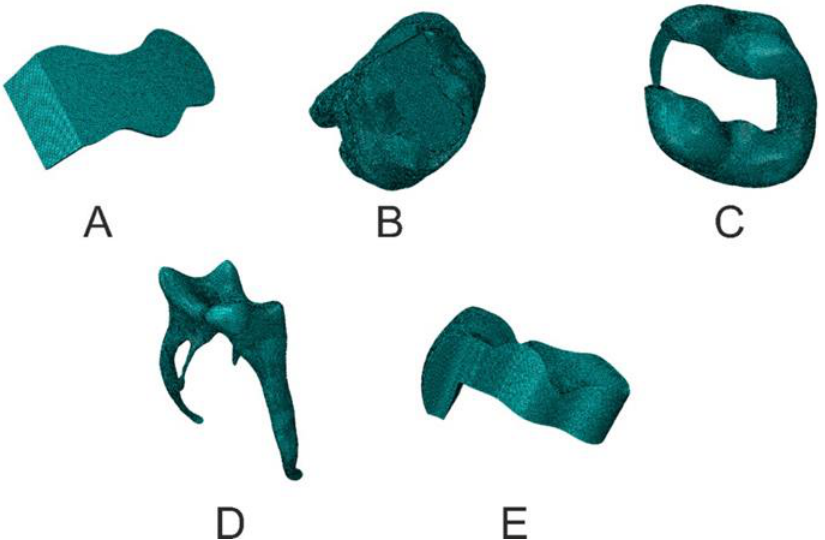
Figure 3. Geometric construction of molar tooth, restoration, and cement. ( A ): cement, ( B ): dentin, ( C ): enamel, ( D ): pulp, ( E ): restoration. The enamel, dentin, resin cement, and material characteristics were assumed to be isotropic and linearly elastic to simplify the complexity of the three-dimensional finite element models. The models were assigned the properties of the teeth and the materials, and the relevant data are presented in Table 1. Table 1. Mechanical properties of the material used in 3D FE models of maxillary molars.